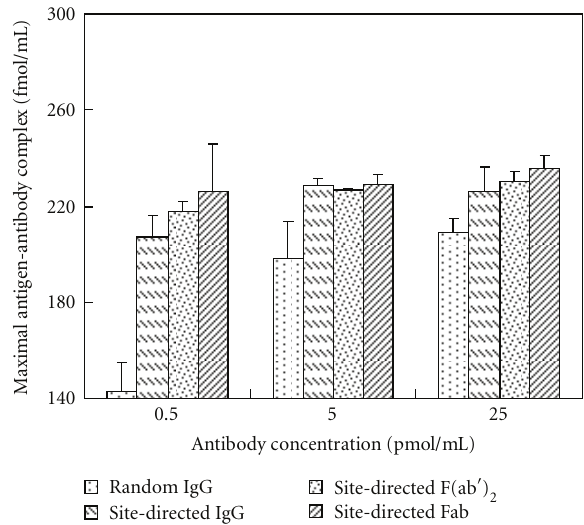
Figure 5: Comparison of binding a ffi nities for the four di ff erent antibody preparations, as described in Figure 3, when plotted against the concentration added. The a ffi nity was measured simul- taneously with the surface density by means of Scatchard analysis. Each measurement were repeated three times and the resulting deviations were